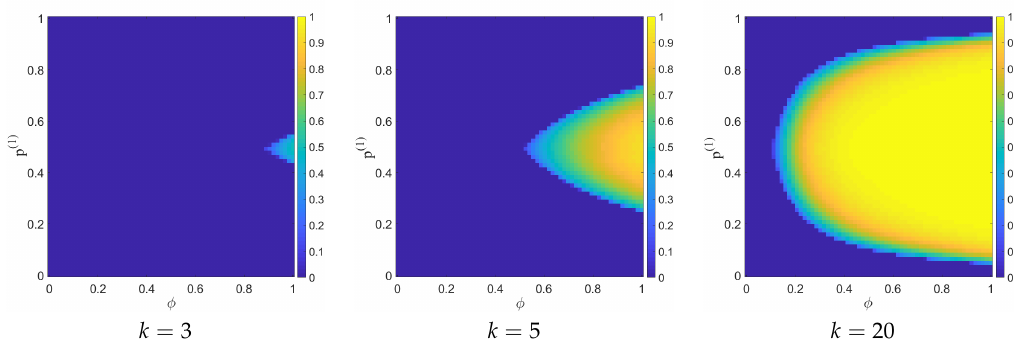
Figure 2. Phase planes of the bond CAP for two exclusive colors (denoted color 1 and 2). assigned to sites with probability p ( 1 ) and p ( 2 ) = 1 − p ( 1 ) and different dilutions (different